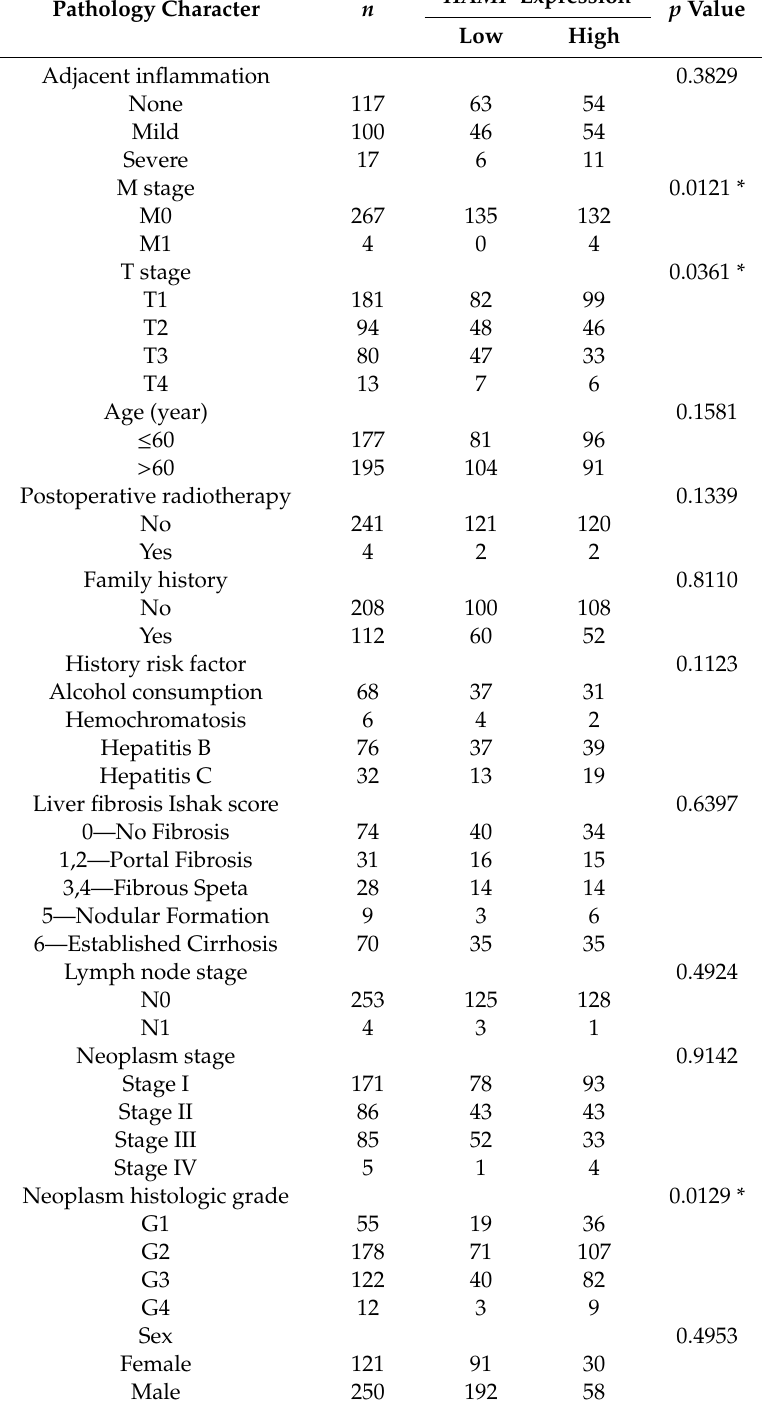
Table 1. Clinical characteristics according to HAMP expression in liver hepatocellular